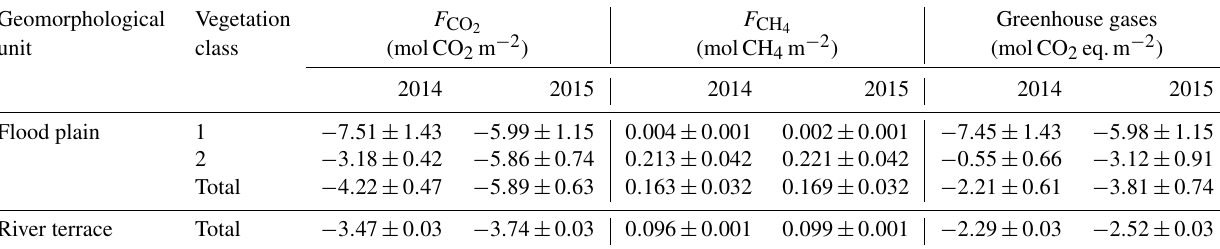
Table 2. Comparison of the sink/source strengths between flood plain and river terrace for the comparison periods in 2014 and 2015 (Holl et al., 2019; Rößger et al., 2019a). Accounting for methane’s radiative efficiency as a potent greenhouse gas, the methane budgets were converted to carbon dioxide equivalents with a factor of 34, which corresponds to methane’s global warming potential based on a time horizon of 100 years including climate carbon feedbacks (Myhre et al., 2013). The flood plain budgets are given for each vegetation class and for the total area. These budgets are the result of a scaling procedure, which included fairly large classification errors that caused distinctly greater uncertainties in comparison to the river terrace budgets, which derived from a representative footprint and hence did not undergo any scaling processes. In comparison to the flood plain, the polygonal tundra on the river terrace took up less carbon dioxide per square metre, but also released less methane, resulting in a similar (2014) and weaker (2015) sink strength for greenhouse